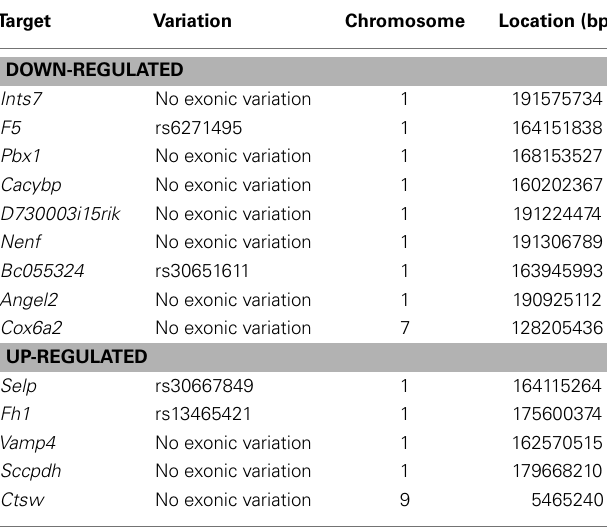
Table 1 | List of known SNPs within differentially expressed genes in Ity3 and Ity3.RecN .